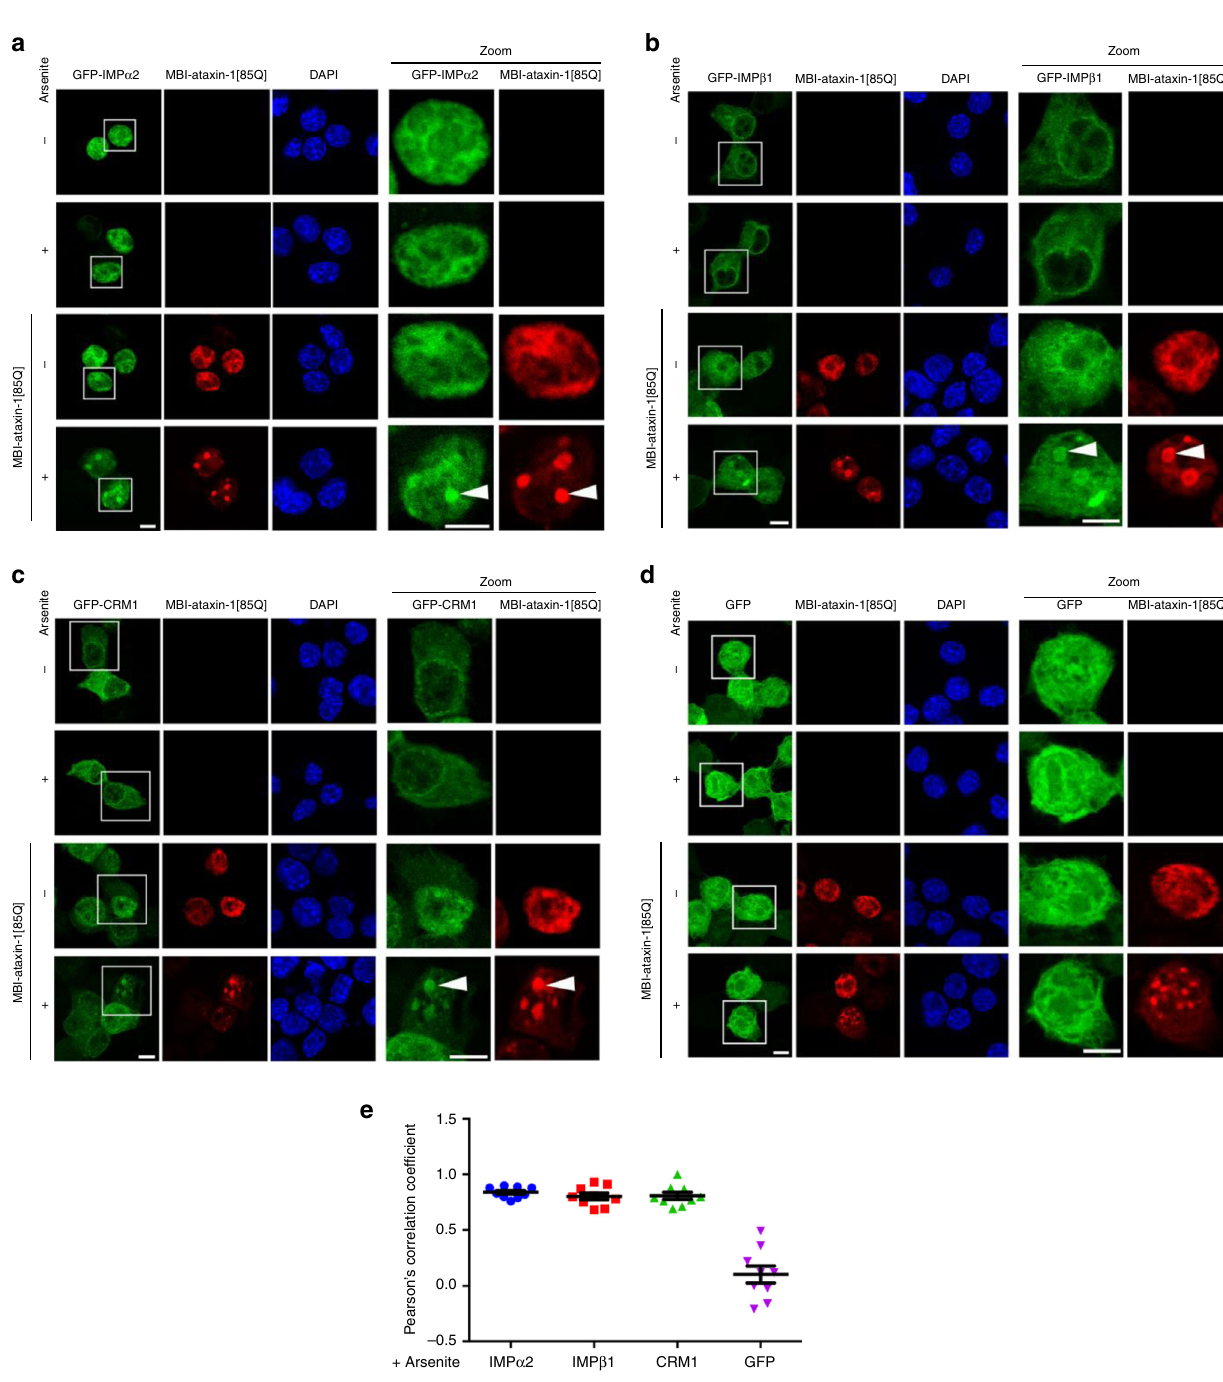
Fig. 3 Ataxin-1[85Q] induces mislocalisation of classical nuclear transport proteins. Neuro-2a cells were cotransfected to express MBI-ataxin-1[85Q] together with ( a ) GFP-Importin- α 2 (IMP α 2), ( b ) GFP-Importin- β 1 (IMP β 1), ( c ) GFP-CRM1, or ( d ) GFP alone. At 24 h post-transfection, cells were treated with arsenite as indicated, and then fi xed, stained with anti-myc antibodies and DAPI, before CLSM imaging. Representative images of cells are shown, with zoom images (right panels) corresponding to the boxed regions. Mis-localisation to the ataxin-1 nuclear bodies is indicated by the white arrowheads. Scale bar = 10 μ m. e Pearson ’ s correlation coef fi cients, calculated using the coloc2 plugin for localisation between fl uorophores in a 25 μ m 2 square centred over each arsenite-induced ataxin-1 nuclear body, quantitatively assessed co-localisation of GFP-tagged proteins with ataxin-1 nuclear bodies, where 0 indicates no correlation between two channels whereas 1 indicates complete correlation of two channels. Results represent the mean ± SEM ( n = 9 cells imaged across three independent experiments). Source data are provided as a Source Data fi association in vivo 9 . In contrast, our assessment of endogenous the potential to reduce nuclear RanGTP levels, and hence RCC1 detected with an anti-RCC1 antibody or ectopically addressed GFP-RCC1 revealed localisation with polyQ-ataxin-1 nuclear bodies (Supplementary Fig. 9). Thus, through mis- localising RCC1 into distinct nuclear bodies, polyQ-ataxin-1 has